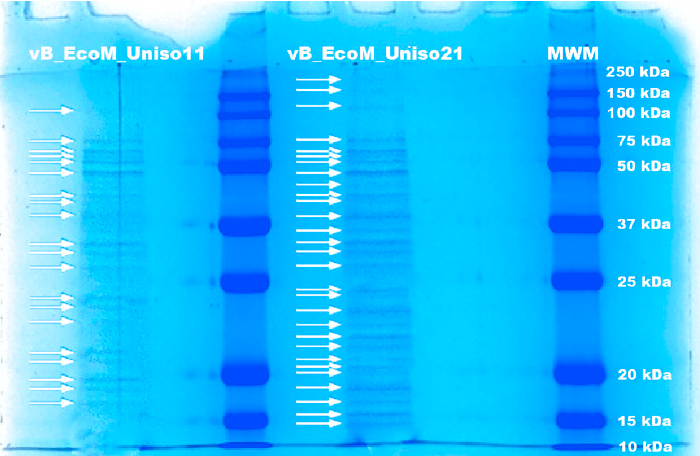
Figure 9. Coomassie-stained electrophoretogram of structural proteins of phages vB_EcoM_Uniso11 and vB_EcoM_Uniso21, and wide-range molecular weight markers (lane MWM).